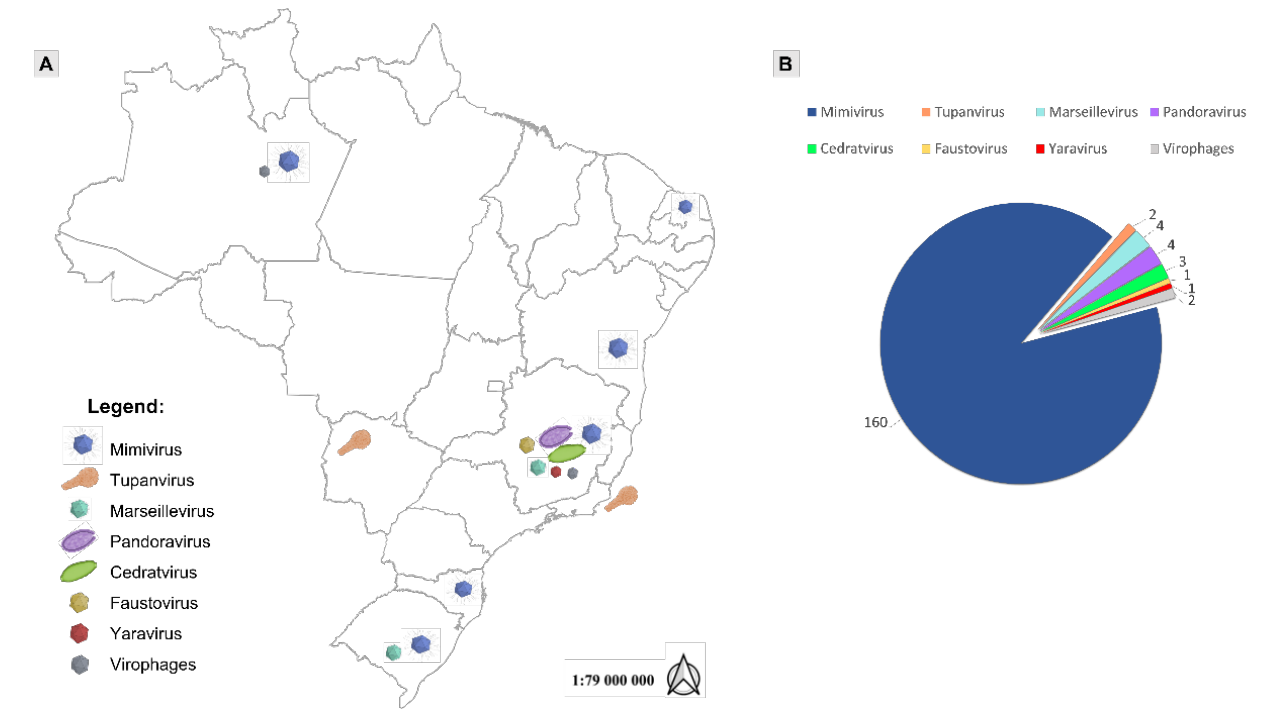
Figure 1. Location and numbers of giant viruses isolated in Brazil. ( A ) Schematic map showing the sites of isolation for the major groups of giant viruses discovered in Brazil. ( B ) Number of isolates discovered for each of these groups.